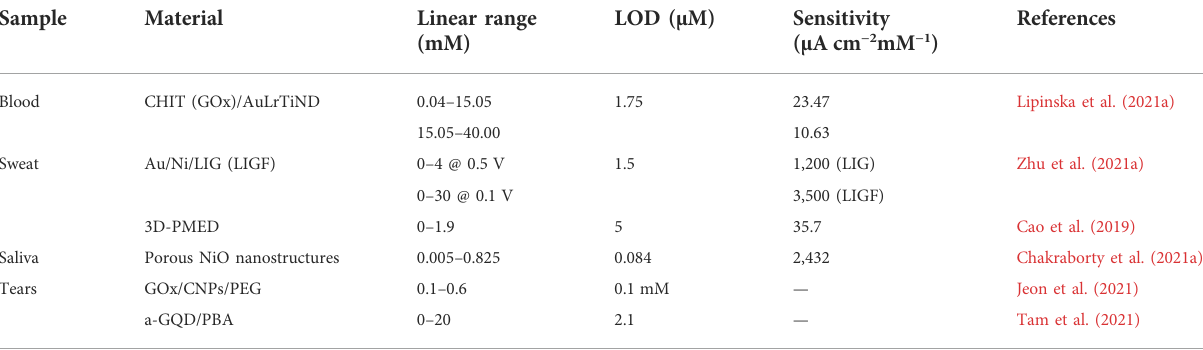
TABLE 1 Invasive and non-invasive glucose sensors, with analytical characteristics.